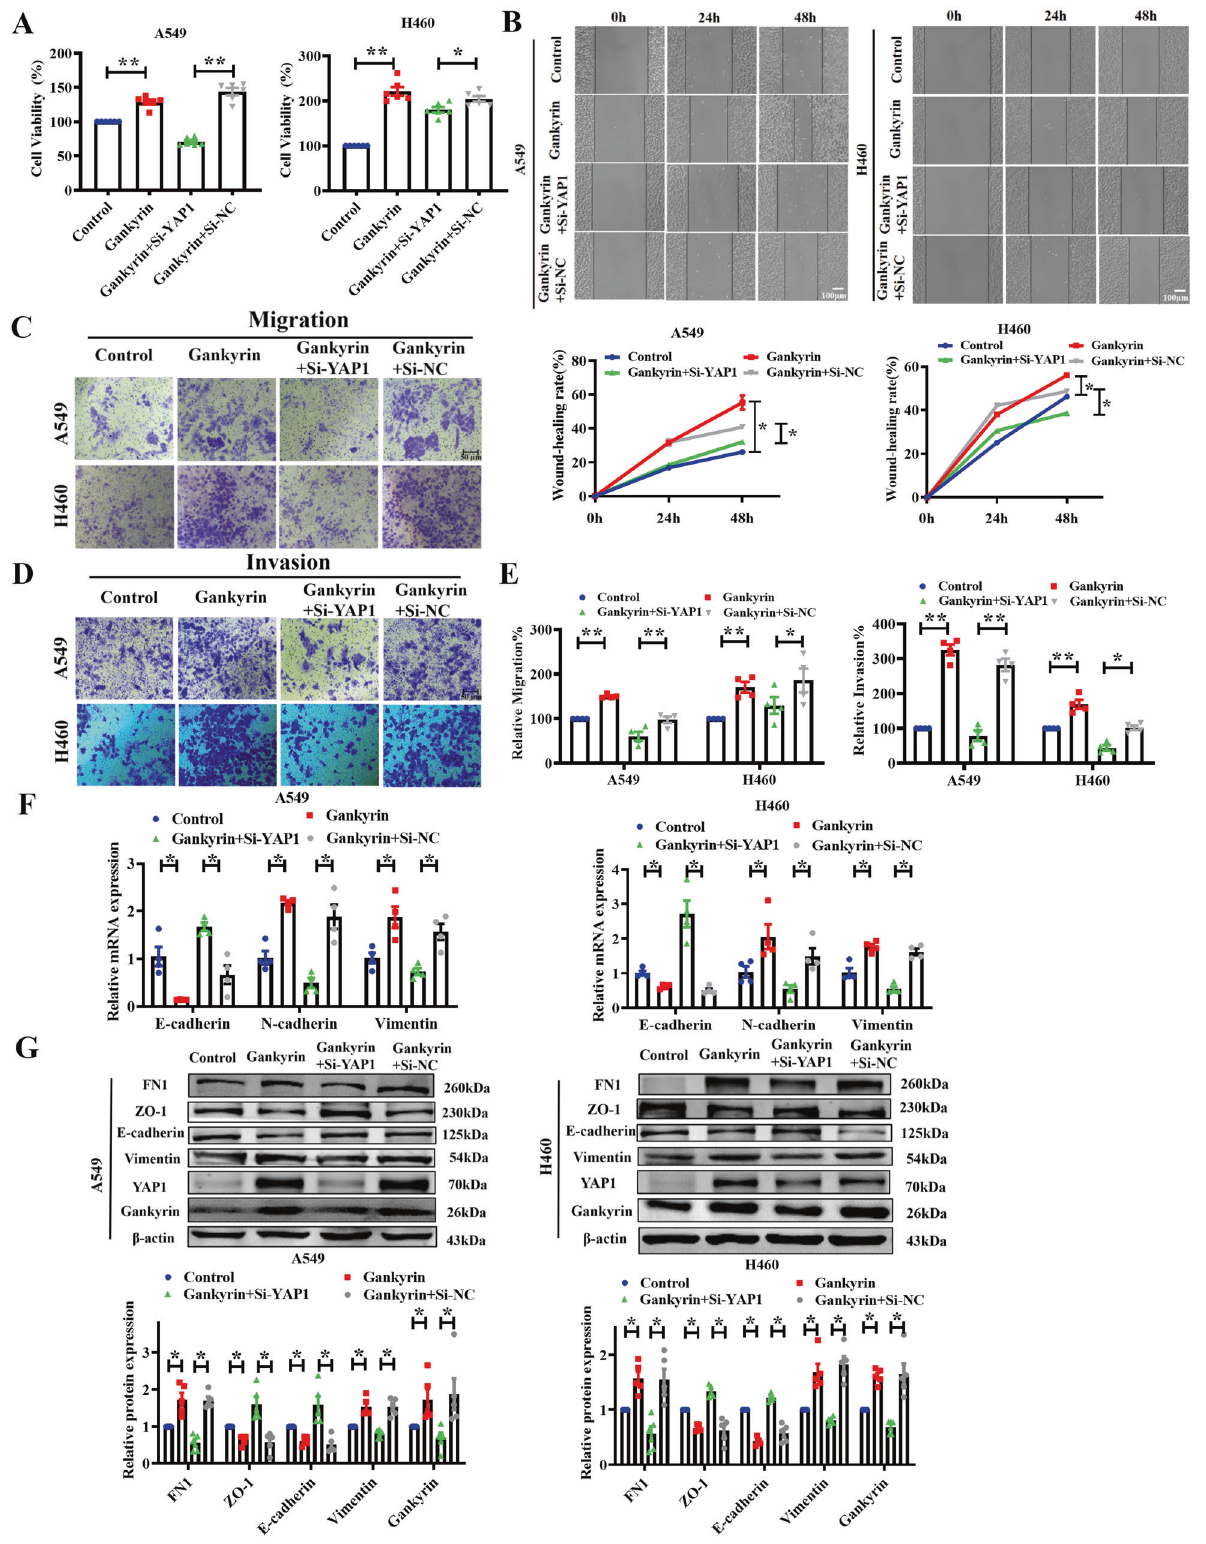
Fig. 5 Gankyrin promotes EMT progression through YAP1 regulation. A Viability of A549 and H460 cells determined using MTT assay ( n = 6, * P < 0.05, ** P < 0.01). B Wound-healing assays show the motility of A549 and H460 cells ( n = 5, * P < 0.05, Scale bars: 100 μ m). C , D Representative images of transwell migration and Matrigel invasion assays in A549 and H460 cells (Scale bars: 50 μ m). E Statistical analysis of migration and invasion in A549 and H460 cells ( n = 4, * P < 0.05, ** P < 0.01). F mRNA levels of the EMT-relevant markers E-cadherin, N-cadherin, and Vimentin in A549 and H460 cells ( n = 4, * P < 0.05). G Protein levels of the EMT-relevant markers E-cadherin, N-cadherin, and Vimentin in A549 and H460 cells ( n = 5, * P < 0.05).